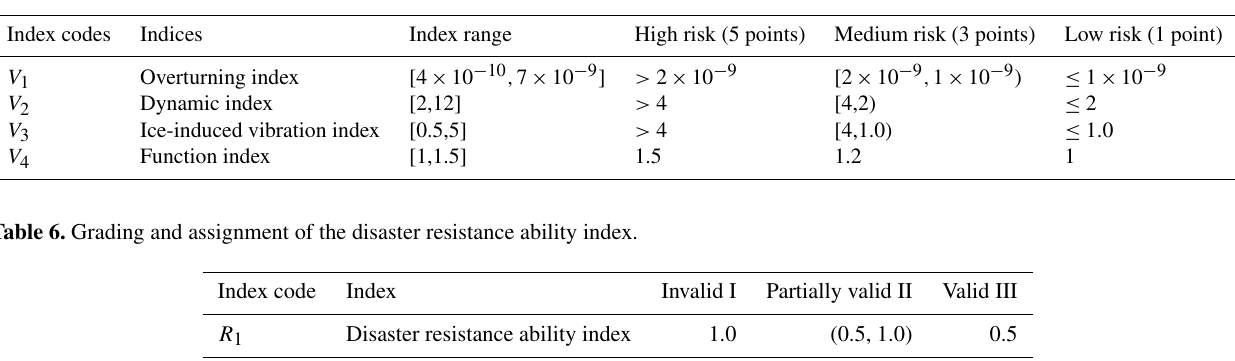
Table 5. Grading and assignment of structural vulnerability indices.